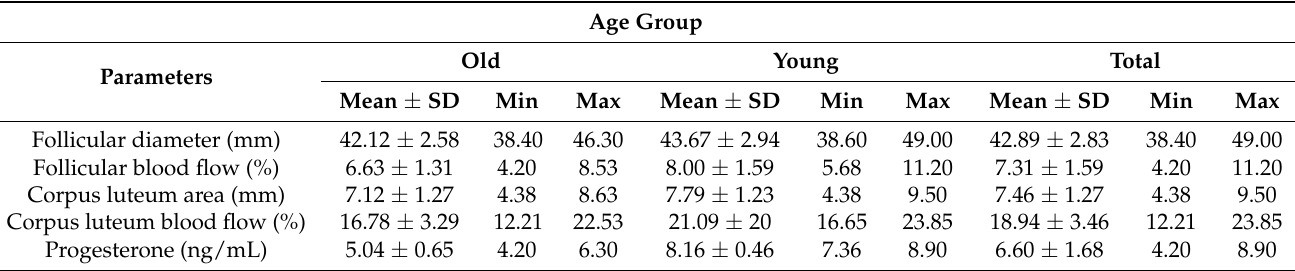
Table 1. Mean ± standard deviation (SD), minimum (Min) and maximum (Max) values of the follicle and corpus luteum ultrasonic parameters and blood plasma progesterone concentration from mares included in the study (n = 30). Age Group Old Parameters